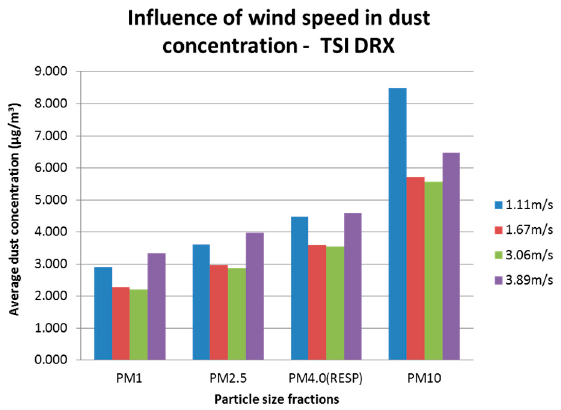
Figure 12. Influence of wind speed variation over dust concentration (raw) for different particle size fractions reported by the TSI DRX.